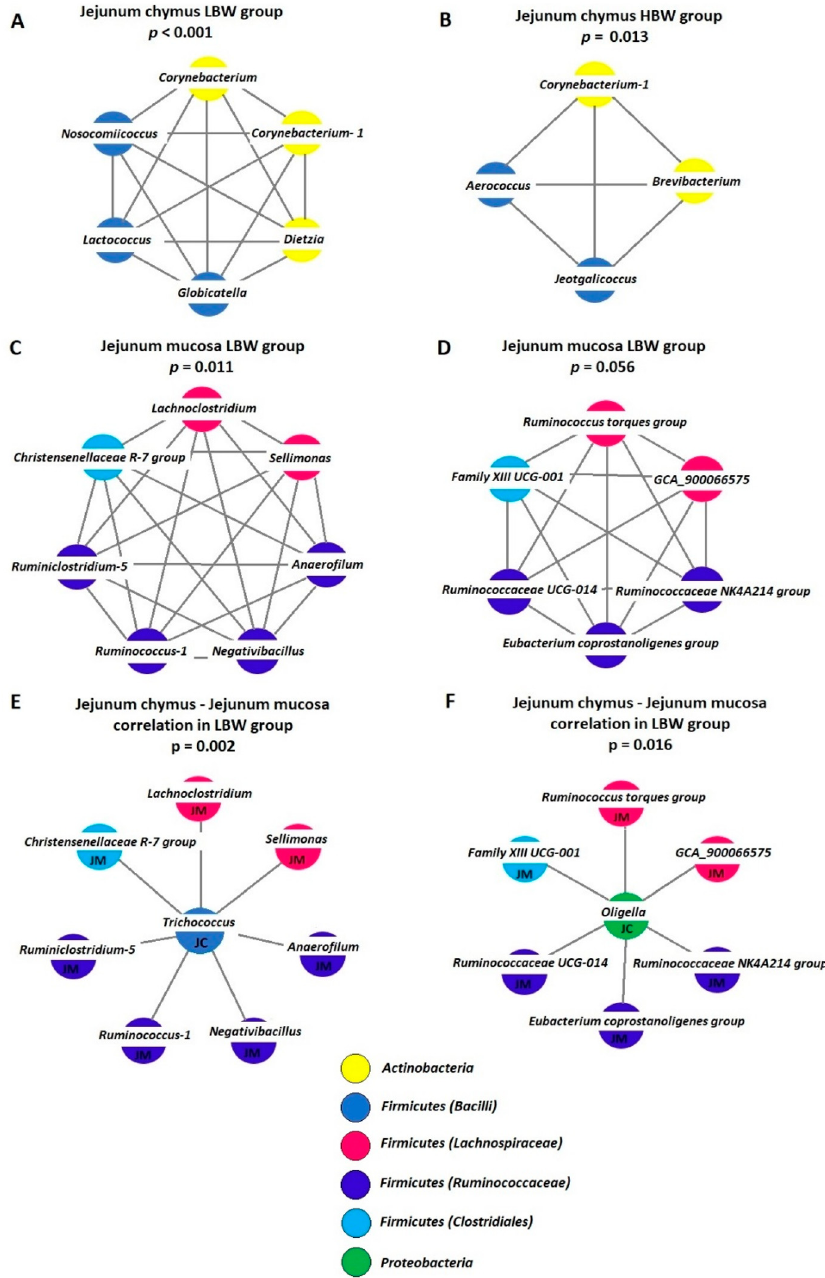
Figure 2. Co-occurrence patterns in the sampling places and changes in different body weights. ( A ) Genus correlations in jejunum chymus LBW; ( B ) jejunum chymus HBW; ( C , D ) jejunum mucosa LBW groups. ( E , F ) Jejunum chymus-jejunum mucosa connection in the LBW